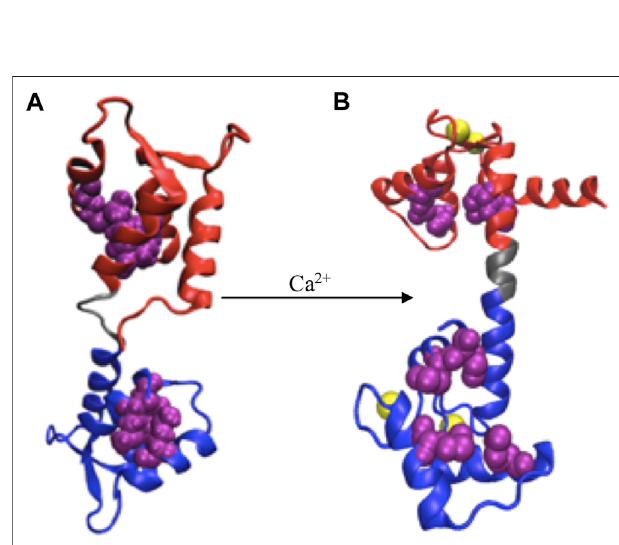
FIGURE 2 | Ca 2+ induced conformational change. (A) apoCaM, (B) holoCaM. Ca 2+ ions are shown in yellow spheres, the N-terminal and C-terminal domains of CaM are shown in red and blue, respectively, and the central linker is shown grey. Upon conformational change, the four methionine residues (shown as beads in purple), initially buried inside the EF- hands, are exposed to the solvent.